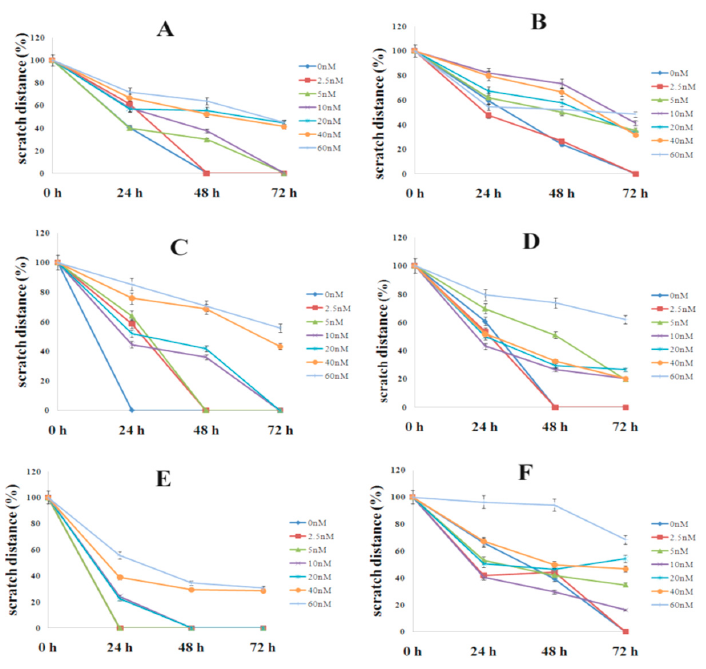
Figure 6. Antiproliferative effect of colchicine on cell migration. Cells were treated with varying doses of colchicine (2.5–60 nM) and the distance they moved was measured using a scratch assay at different time-points (0, 24, 48, and 72 h). Each line is labeled with the drug concentrations used in the experiment. ( A ) A549, ( B ) HCT116, ( C ) SiHa, ( D ) PANC-1, ( E ) MDA-MB231, and ( F ) MCF-7. Molecules 2018 , 23 , x